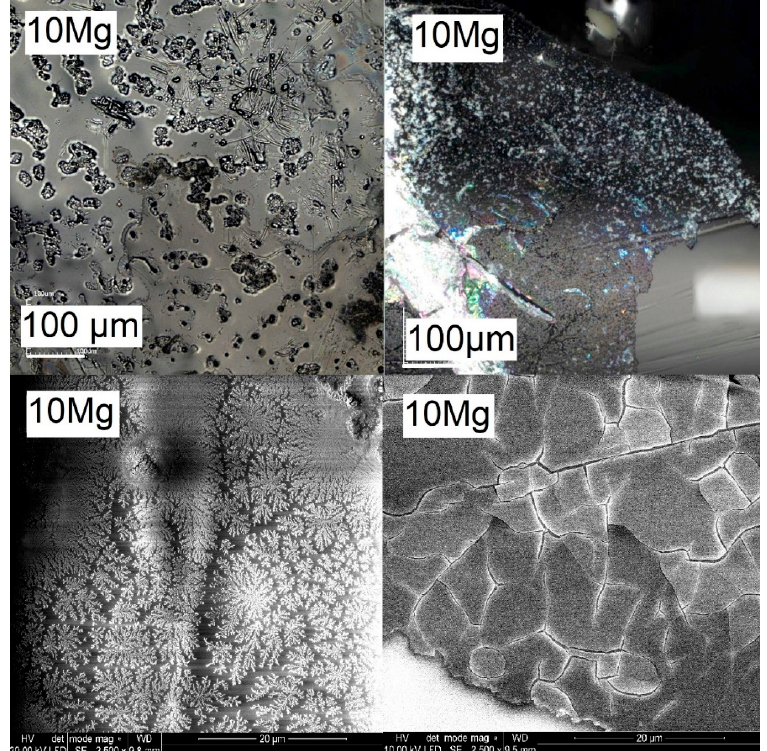
Figure 8. Confocal microscope (top) and SEM (bottom) micrographs after 8 (left) and 15 (right) days of incubation in the PBS for glass 10Mg.